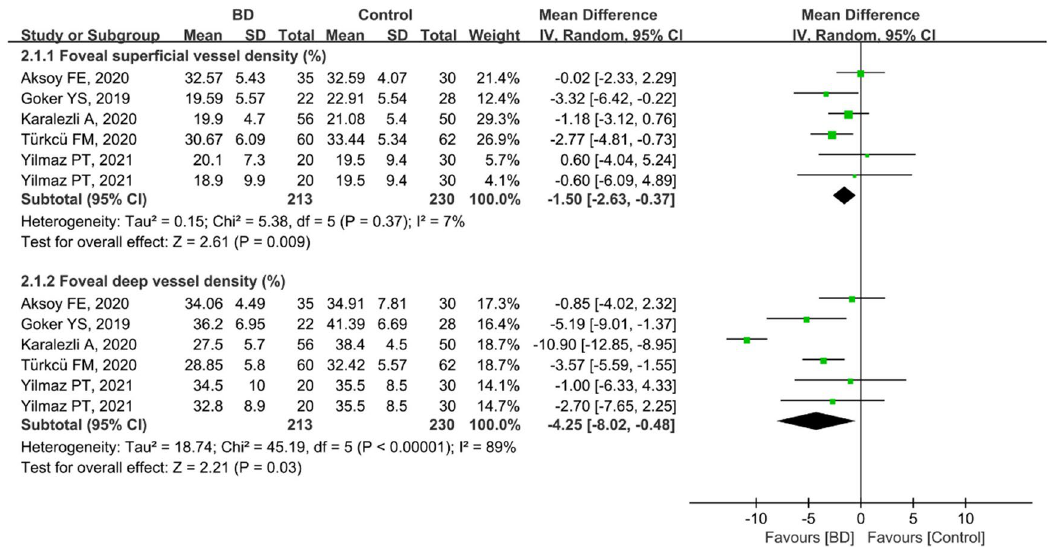
Figure 5. Forest plot for foveal superficial and deep vessel density between BD and control groups.